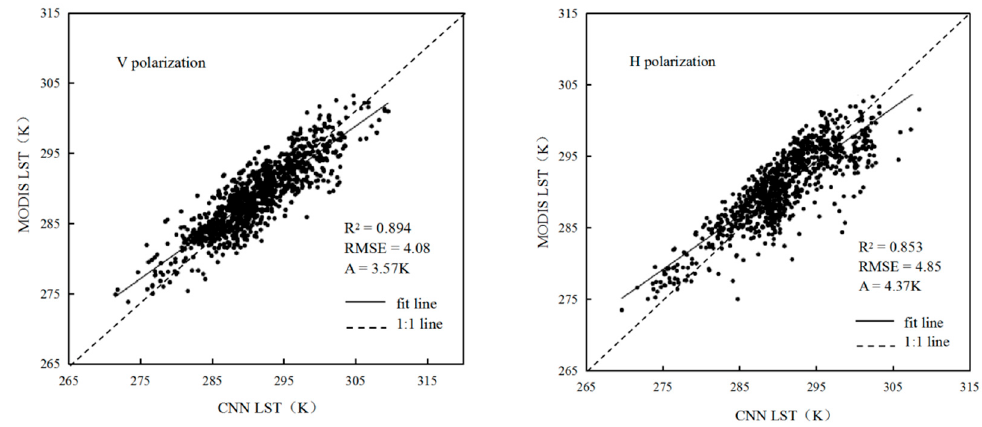
Figure 5. Scatterplots of CNN retrieval results (V/H) and MODIS LST data.